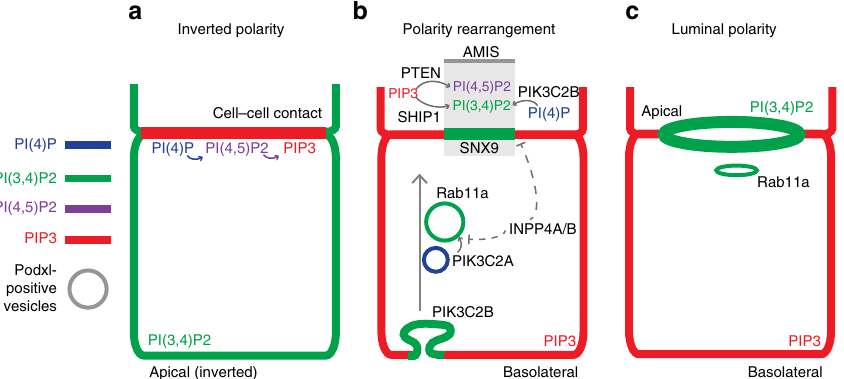
Fig. 10 Model of PIP rearrangements during lumen formation. Shortly after plating into 3D, single MDCK cells undergo morphogenesis to form a cell doublet with initially inverted polarity a , whereby the apical surface marked by Podxl abuts the ECM. At this stage, a PI(4)P>PI(4,5)P 2 > PIP 3 cascade de fi nes the cell – cell contact, while PI(3,4)P 2 is inverted. b To reorient polarity, peripheral Podxl internalizes into vesicles which are initially PI(3)P and/or PI(4)P positive, before progressively enriching to become PI(3,4)P 2 /Rab11a-positive. These vesicles target to the apical membrane initiation site (AMIS). The PI(3,4)P 2 -promoting Class-II PI3Ks PIK3C2A/B promote, whereas the PI(3,4)P 2 -degrading phosphatases INPP4A/B inhibit, this process. Concomitantly, the AMIS is formed by two PIP phosphatases, PTEN and SHIP1, which focally convert PIP 3 into, PI(4,5)P 2 or PI(3,4)P 2 , respectively to form this zone for apical vesicle delivery. c Upon delivery of transcytosing Podxl, de novo lumen formation is completed, leaving cortical PI(4)P and PI(4,5)P 2 , basolateral PIP 3 , and apical and recycling endosome PI(3,4)P